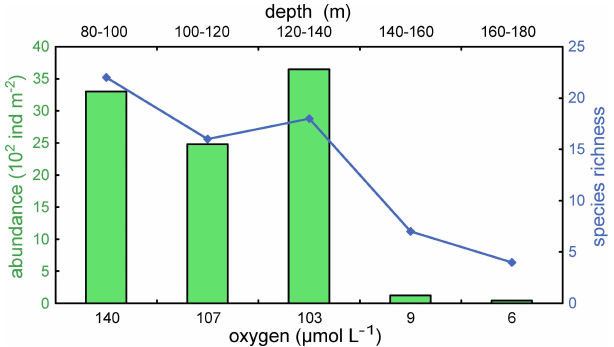
Fig. 22. Dependence of the abundance and species richness of the macrobenthos in the Bosporus area on water depth and on the dissolved-oxygen concentration measured just above the